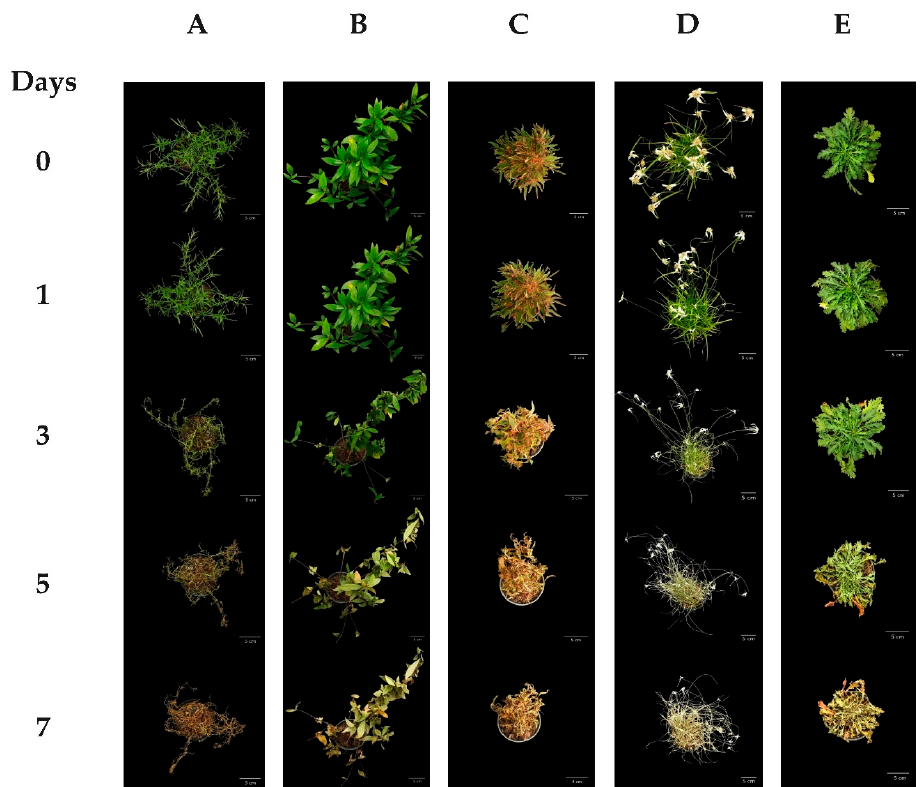
Figure A3. Images of plants under the drought treated condition at 5 times intervals: 0, 1, 3, 5, and 7 days after of the start of the experiment (Coreopsis rosea: A , Trachelospermum jasminoides: B , Acalypha wilkesiana: C , Rhymchospora nervosa: D , Leucanthemum vulgare: E